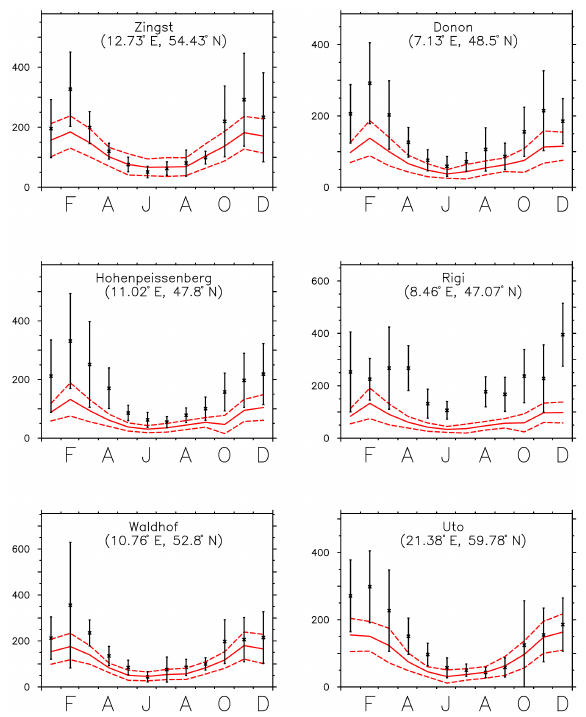
Figure 2. EMEP observations of toluene for six different loca- tions for the year 2005 (monthly average) (in black) and the sim- ulated toluene mixing ratios for the RCP simulation (in red), both in pmolmol − 1 . Error bars show standard deviation of the obser- vations and red dashes show the standard deviation of the model